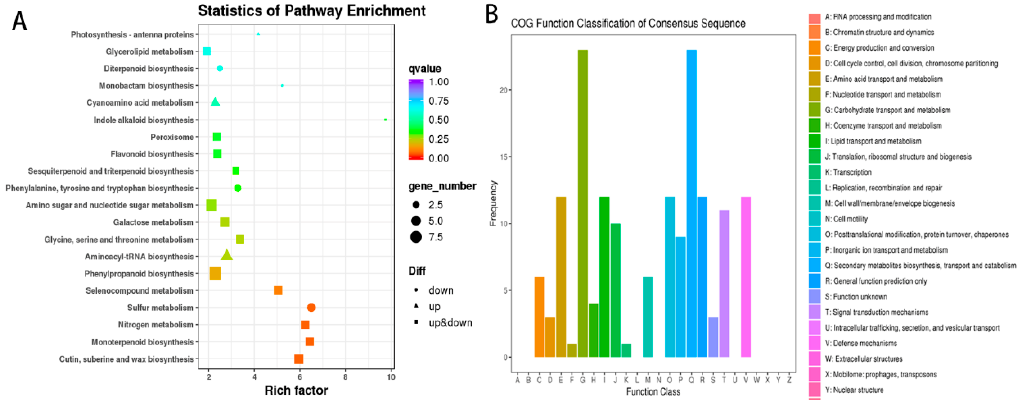
Figure 2. Functional annotation of differentially expressed genes (DEGs) between monocropped and pea intercropped tea plants. ( A ) KEGG pathway enrichment analysis of DEGs; q-value indicate degree of enrichment of DEGs, the lower of q-value, the greater the degree of enrichment; ( B ) COG function classification of DEGs.